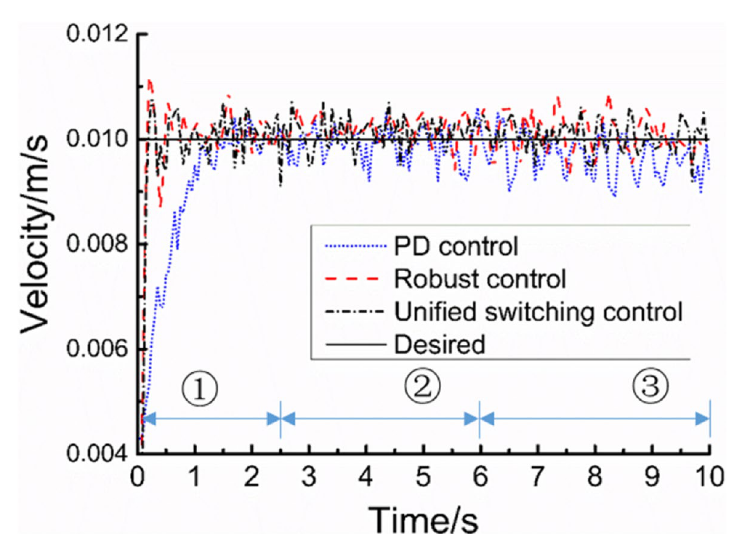
Fig. 8 Speed response under different